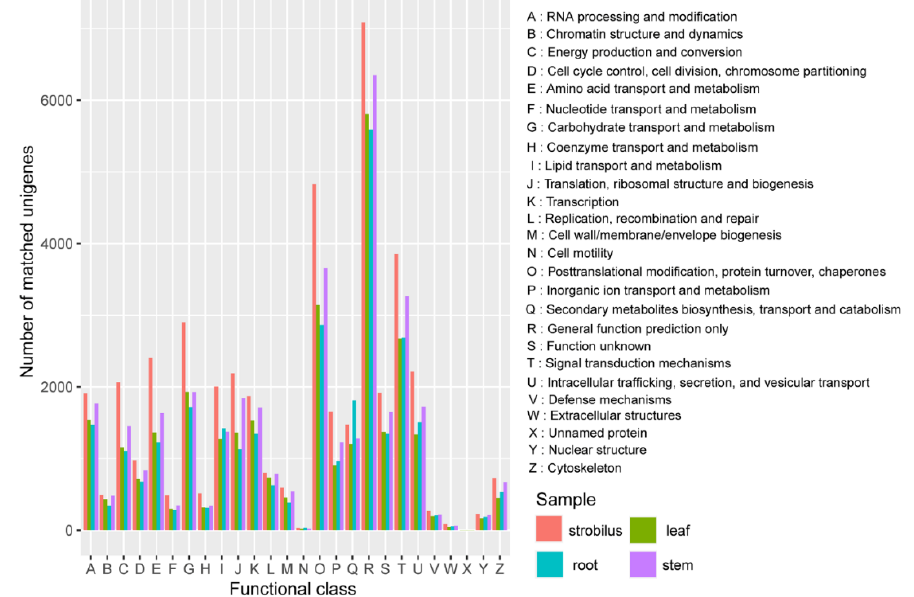
Figure 3. Eukaryotic Ortholog Group (KOG) classification of unigenes.